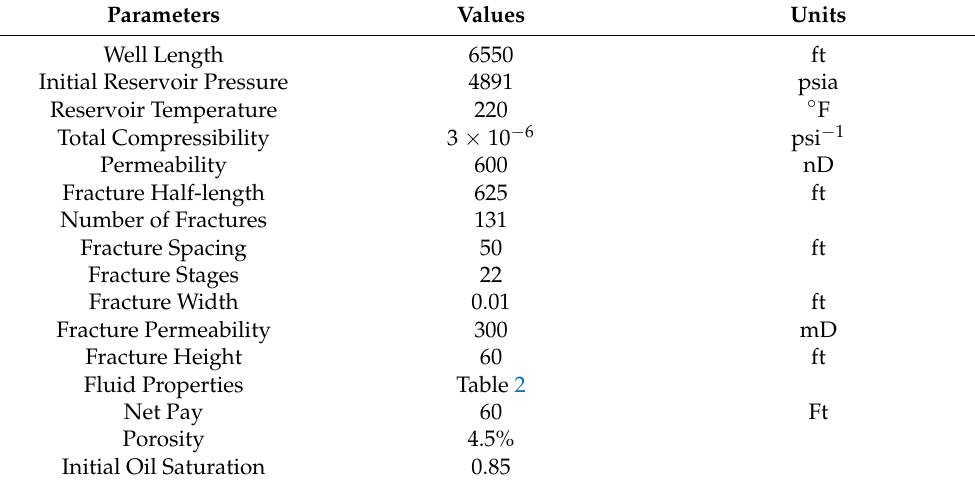
Table 1. Reservoir parameters used for this study.